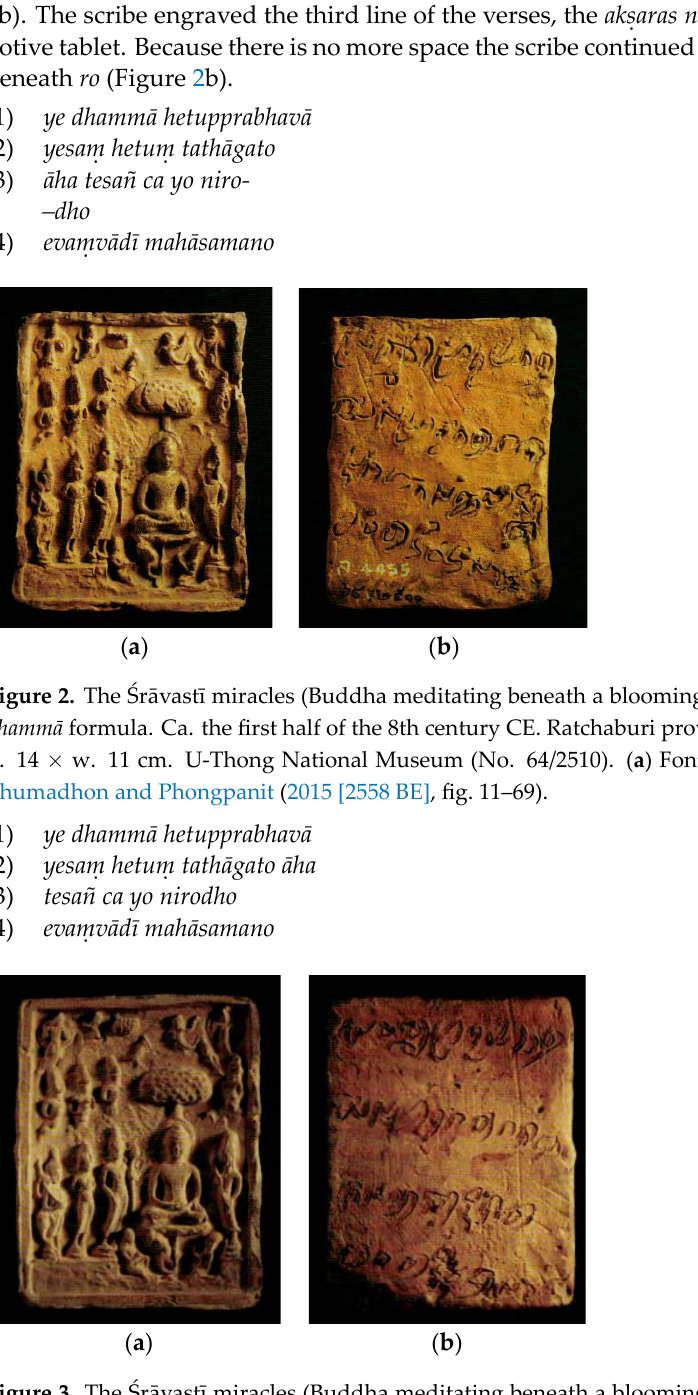
Figure 3. The Śrāvastī miracles (Buddha meditating beneath a blooming tree and the nāga ) with ye dhammā formula. Ca. the second half of the 7th century CE. Ratchaburi province. Moulded tablet, clay; h. 14 × w. 11.5 cm. Ratchaburi National Museum (No. 242/2533). ( a ) Font Side; ( b ) back Side. After Bhumadhon and Phongpanit (2015 [2558 BE], fig. 10 ‐ 8).